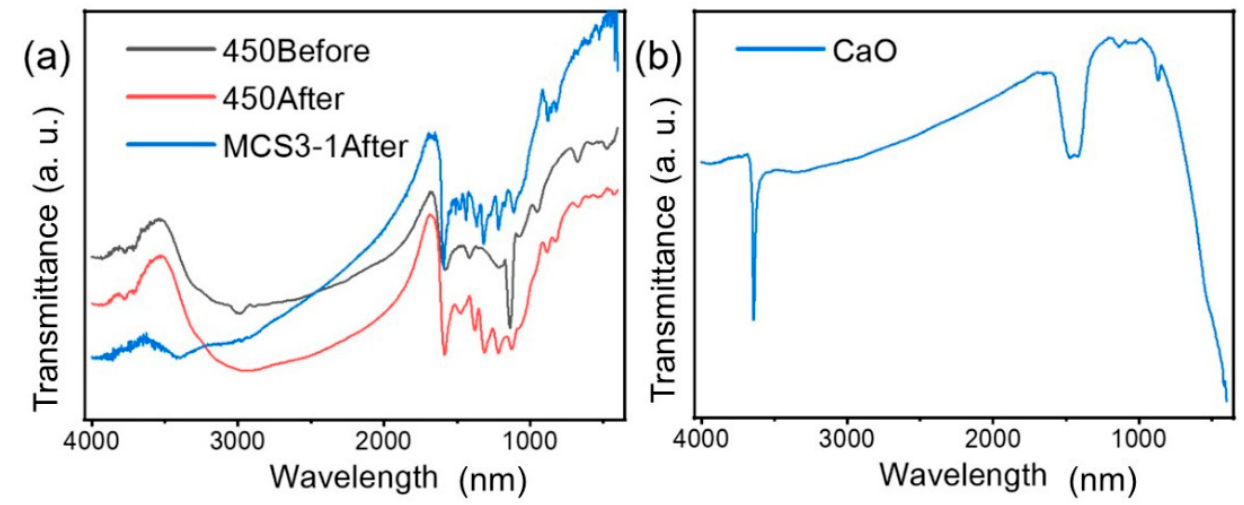
Figure 6. FTIR spectra of ( a ) CN before and after adsorption and ( b ) CaO.